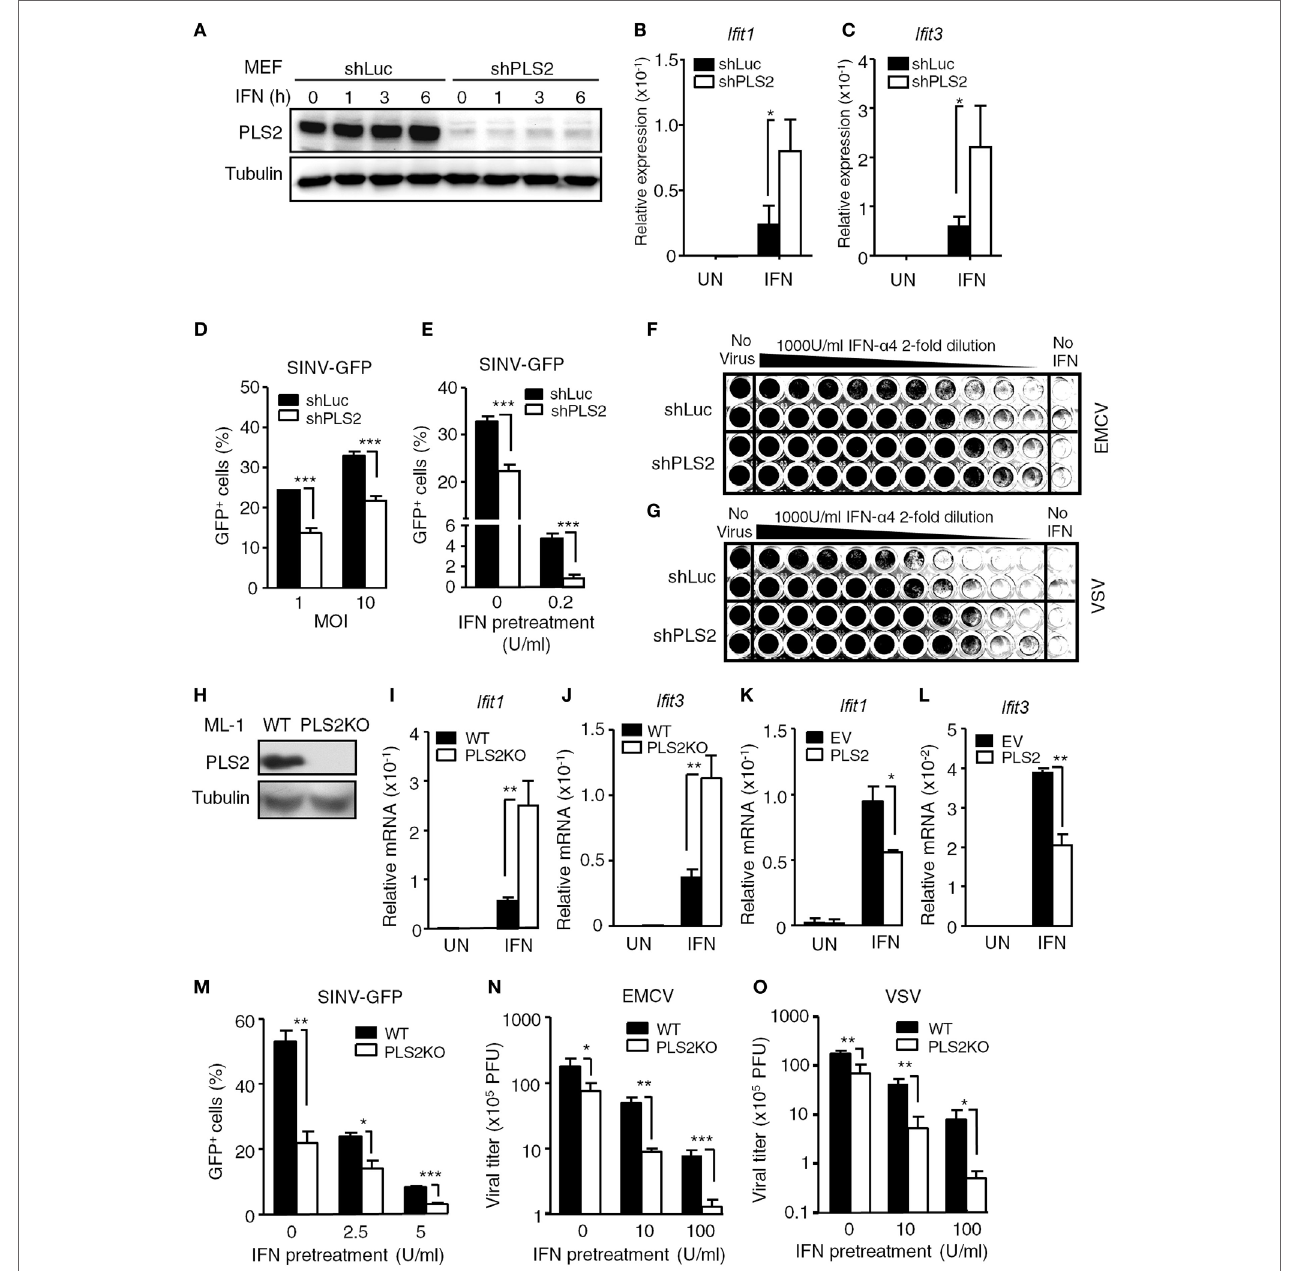
FigUre 2 | Phospholipid scramblase 2 (PLSCR2) suppresses IFN-induced IFN-stimulated gene (ISG) expression and antiviral responses. (a) WT mouse embryonic fibroblasts (MEFs) expressing luciferase- (shLuc) or PLSCR2-specific (shPLS2) shRNA were treated with or without IFN- α 4 (1,000 U/ml) for the indicated times. Total cell lysates were subjected to immunoblotting with antibodies against PLSCR2 or tubulin. Blots are representative of two independent experiments. (B,c) Same as in panel (a) , except cells were treated with IFN- α 4 for 6 h and RNA was subjected to RT-QPCR using primers for Ifit1 (B) , Ifit3 (c) , and β -Actin . Relative mRNA was normalized to β -Actin ( N = 3). (D) shLuc or shPLS2 transduced WT MEFs were infected with Sindbis virus (SINV)-GFP at an MOI of 1 or 10 for 20 h followed by flow cytometric analysis for GFP + cells ( N = 4). (e) Same as in panel (D) , except the cells were pretreated with or without IFN- α 4 (0.2 U/ml) for 24 h and then infected with SINV-GFP at an MOI of 1 ( N = 4). (F,g) shLuc or shPLS2 transduced WT MEFs were pretreated with twofold serial dilution of IFN- α 4 for 24 h before being infected with encephalomyocarditis virus (EMCV) (F) or vesicular stomatitis virus (VSV) (g) at an MOI of 1 for another 24 h. The viable cells were fixed and visualized with crystal violet. (h) Total cell lysates of WT and PLSCR2KO (PLS2KO) ML-1 cells were subjected to immunoblotting with antibodies against PLSCR2 or tubulin. (i,J) WT and PLS2KO ML-1 cells were treated with or without mouse IFN- α 4 for 6 h. Total RNA was subjected to RT-QPCR using primers to Ifit1 (i) , Ifit3 (J) , and Rpl7 . Relative mRNA was normalized to Rpl7 ( N = 7). (K,l) Same as in panel (i) , except PLS2KO ML-1 cells were transfected with empty vector (EV) or vector expressing PLSCR2 for 48 h ( N = 3). (M) WT and PLS2KO ML-1 cells were treated with or without mouse IFN- α 4 at 2.5 or 5 U/ml for 24 h and then infected with SINV-GFP at an MOI of 1 for 20 h followed by flow cytometric analysis for GFP + cells ( N = 3). (n,O) WT and PLS2KO ML-1 cells were pretreated with or without IFN- α 4 at 10 or 100 U/ml for 24 h and then infected with EMCV (n) or VSV (O) at an MOI of 1 for 8 h. The viral titers were determined by plaque formation assay ( N = 3). Data are shown as mean ± SD, * p < 0.05, ** p < 0.01, and *** p <